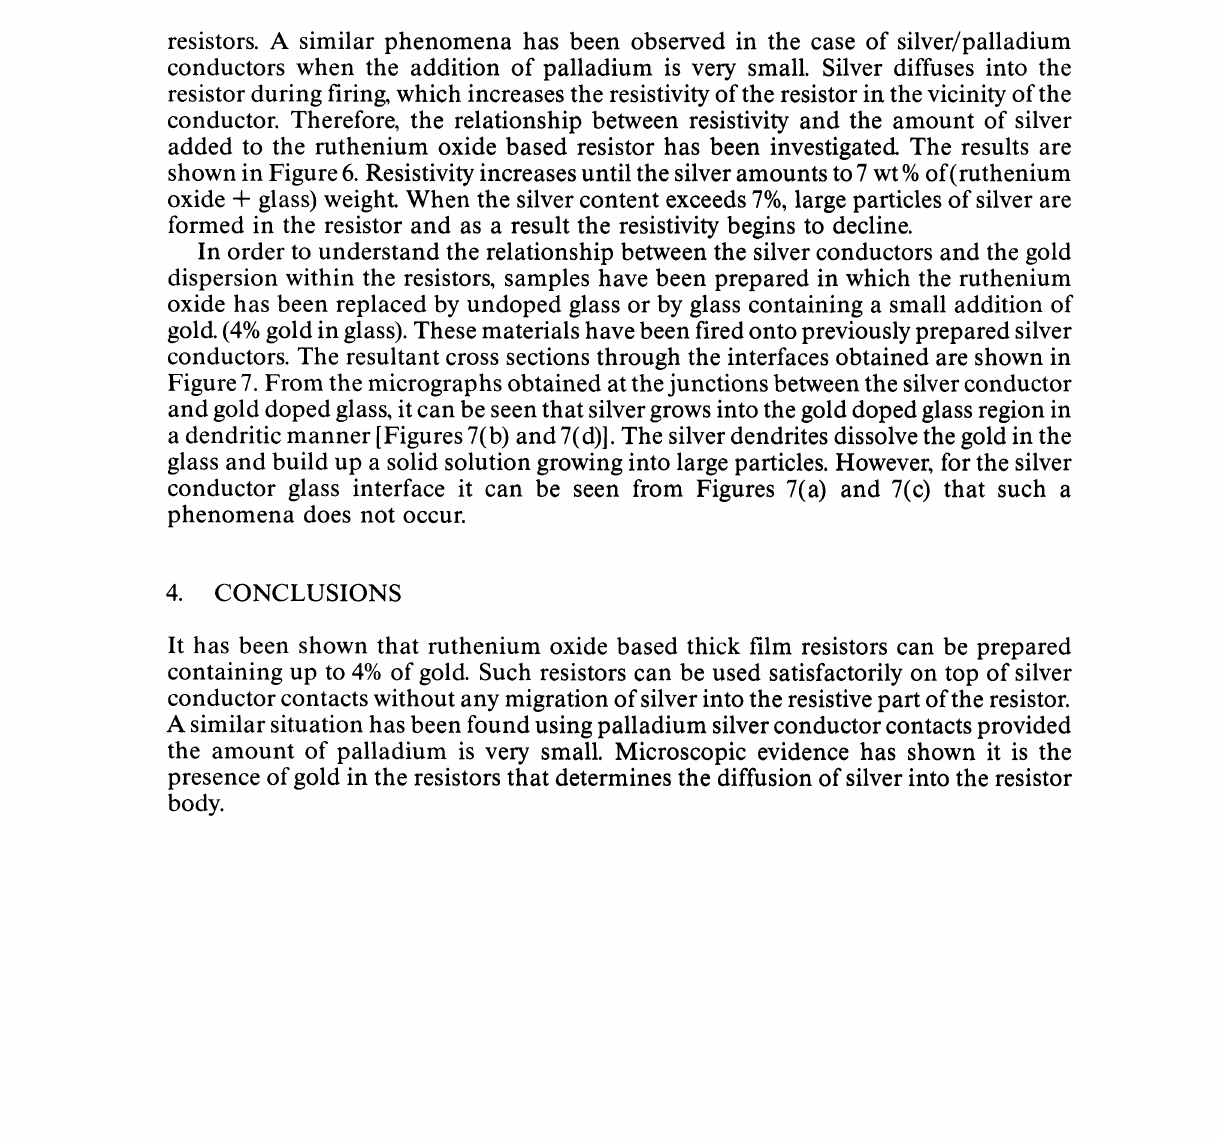
FIGURE 6 Silver content versus sheet resistivity. RuO2/Glass 20/80, Conductor: Silver, Resistor geometry: